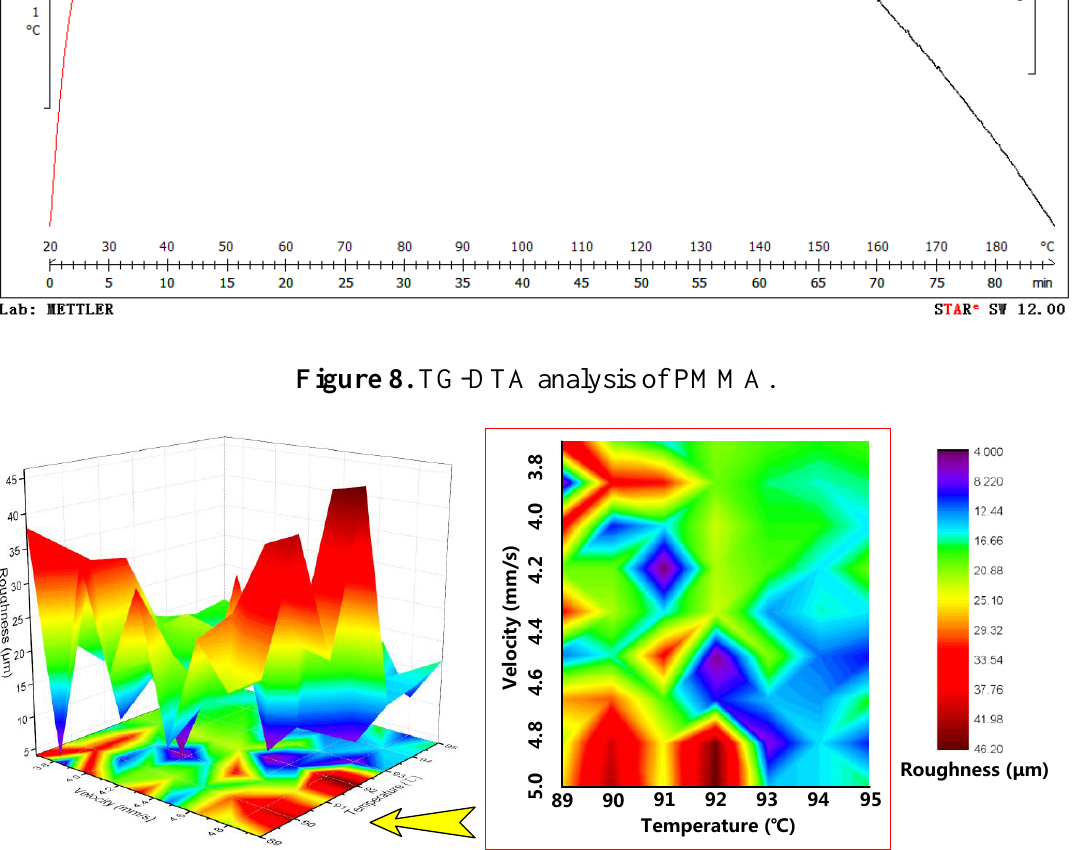
Figure 9. Effect of thermal engraving velocity and temperature on roughness in a 100 μm width